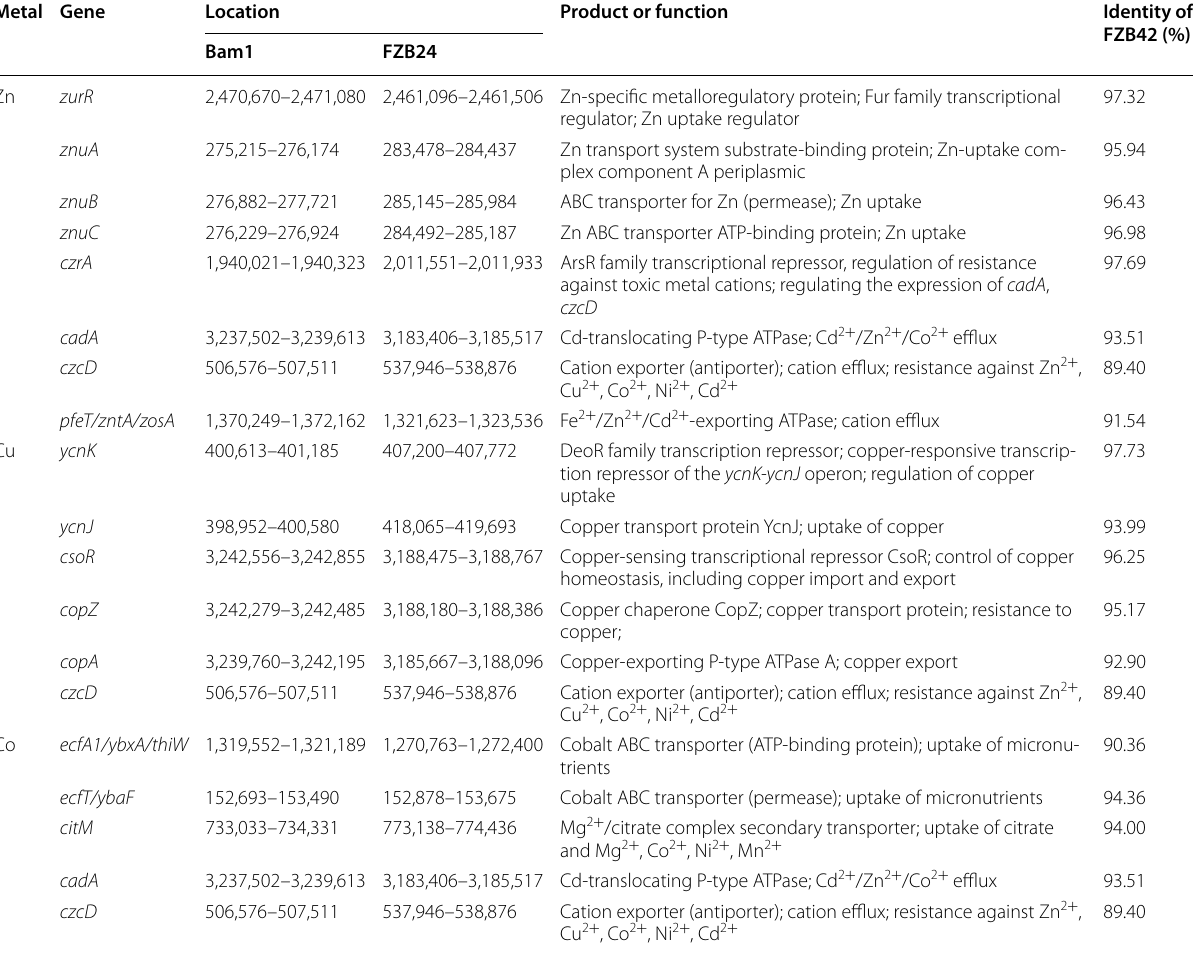
Table 5 Genes involved in Zn, Cu and Co resistance in B. amyloliquefaciens strain Bam1 and B. velezensis strain FZB42 Metal Gene